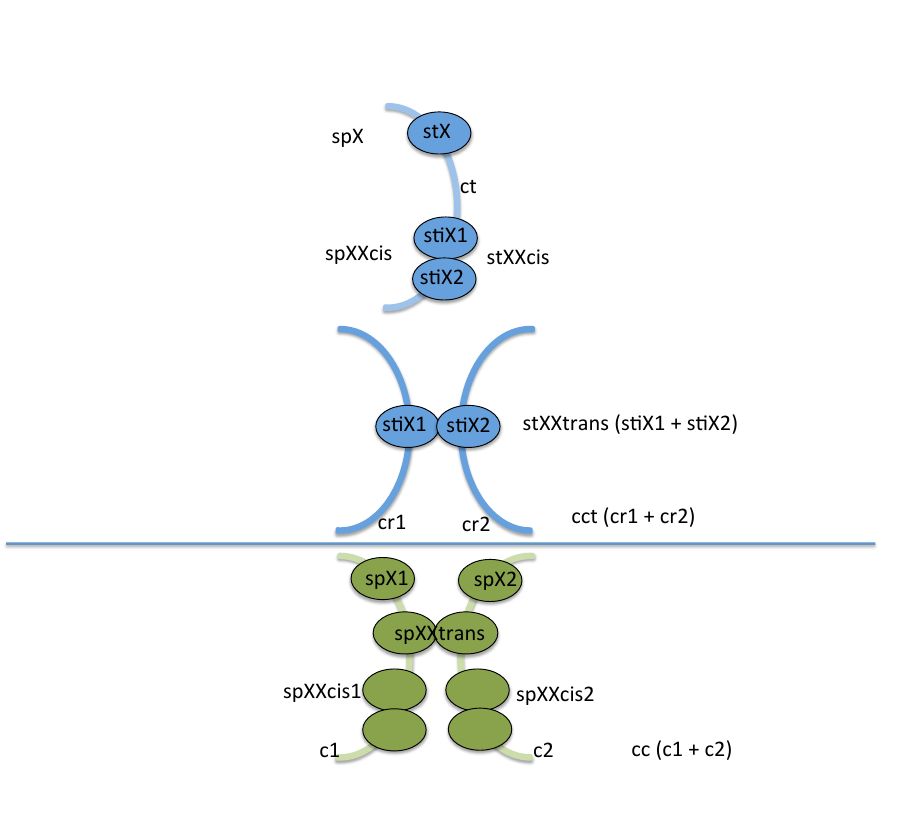
Figure 17: Diagram for an example of Compartment , SpeciesType and